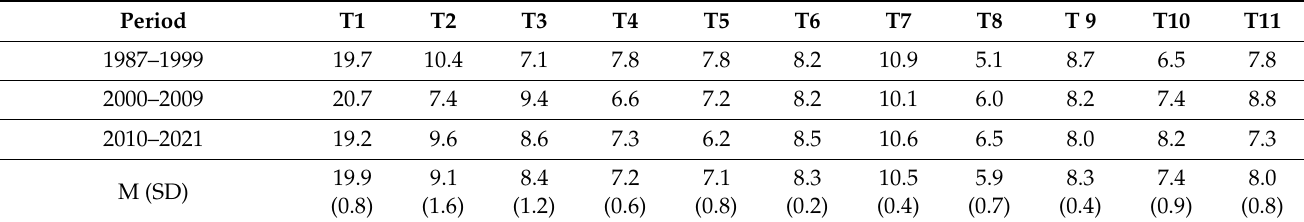
Figure 8. Change in topic proportion by period (%). Table 6. Topic proportion by period (%).